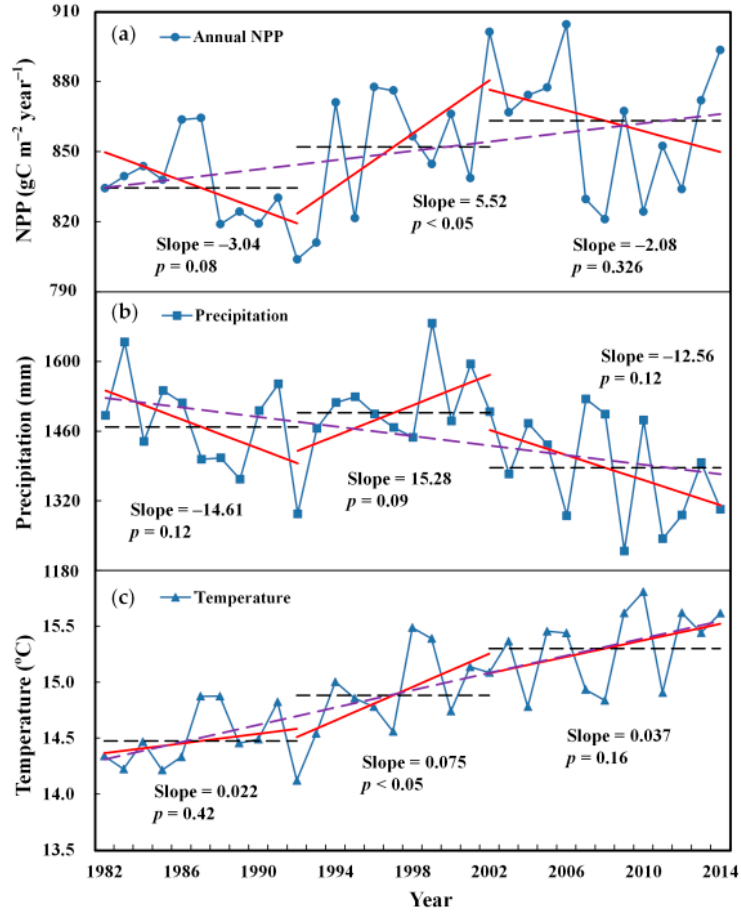
Figure 8. Inter-annual variation of NPP and climatic factors in Yunnan province from 1982 to 2014: ( a ) mean annual NPP; ( b ) annual accumulated precipitation; and ( c ) annual mean temperature. The dotted purple lines are the overall linear regress for the 33 years, the solid red lines show the linear regress for each stage, and the dotted black lines are the mean value for each stages.